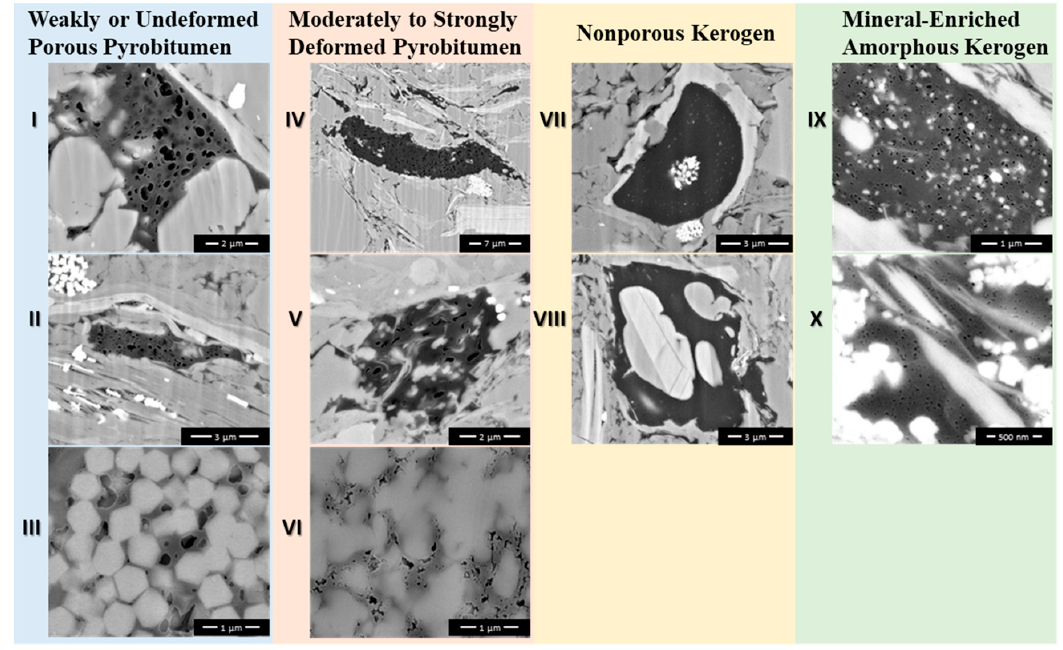
Figure 3. Classification of organic matter particles with high to over mature Longmaxi-Wufeng Shale, Eastern Sichuan Basin. Sample ID of images of I to X is JY1S-9, JY1S-15, JY1S-13, JY8S-5, JY8S-10, JY1S-15, JY1S-9, JY8S-5, JY8S-5, and JY8S-5.